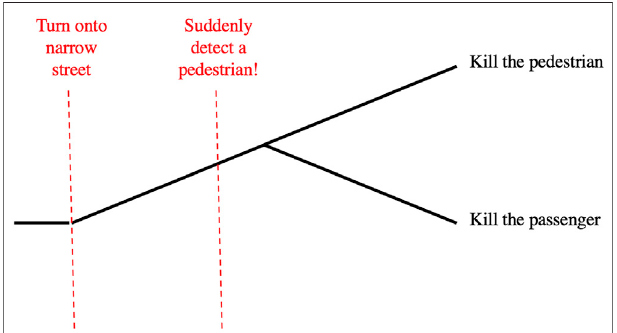
FIGURE 4 | The Deadly Dilemma (abstracted from Awad et al.,